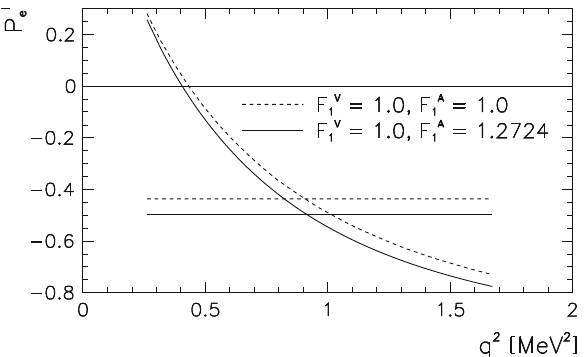
Fig. 2 q 2 dependence of the partial flip and non-flip rates and the total rate